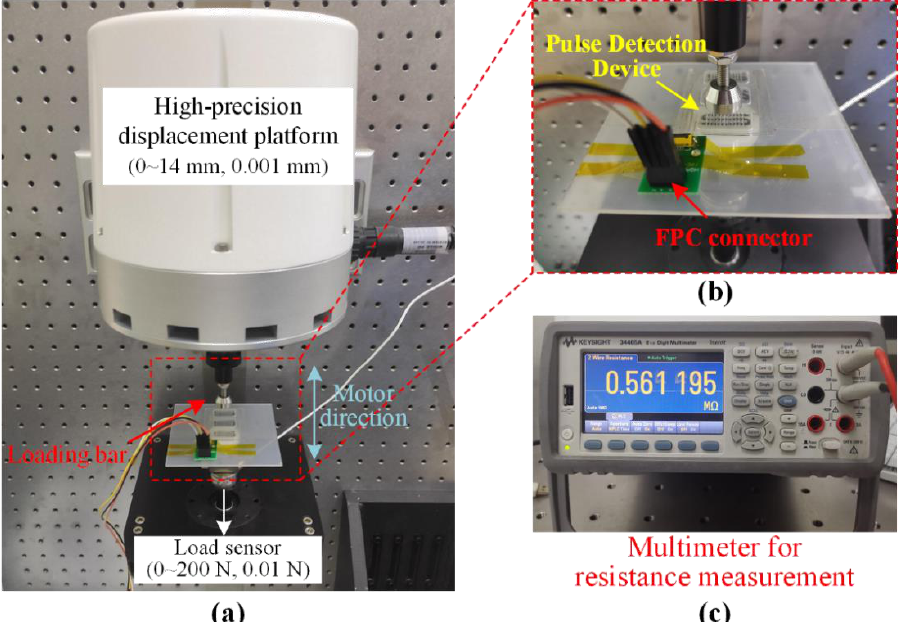
Figure 3. Experimental setup for the characterization of the pulse detection device: ( a ) the perfor- mance testing platform setup for the pulse sensor; ( b ) enlarged view of the device mounting and characterization. ( c ) Numerical multimeter for the pressure sensor’s resistance measurement.